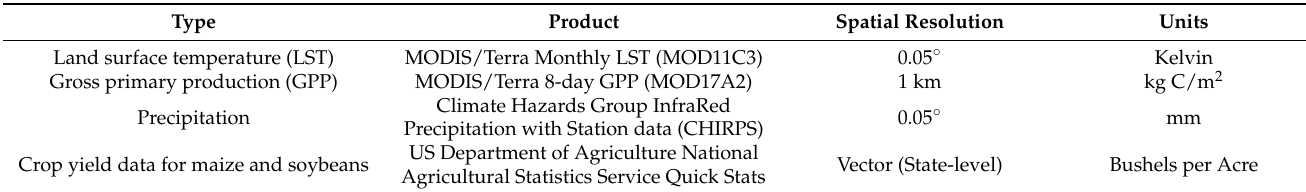
Table 1. Data used in this study. The spatial resolution is described based on the original